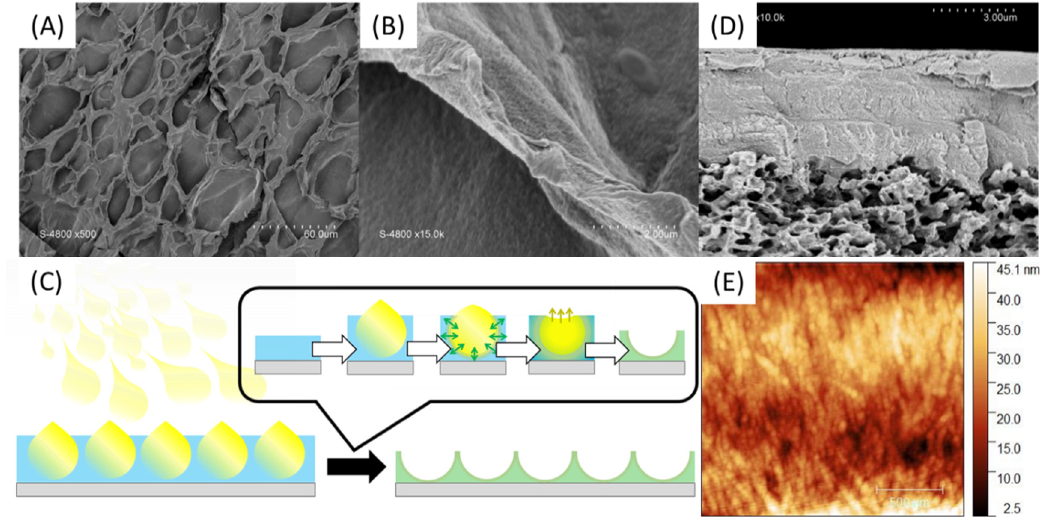
Figure 9. SEM surface pictures of PA-PSSNa self-standing membranes made by tape-casting of a PA solution followed by spray-coating of PSSNa solution ( A , B ) as illustrated in ( C ). SEM pictures of cross section ( D ) and AFM ( E ) of the PVDF-supported membrane.